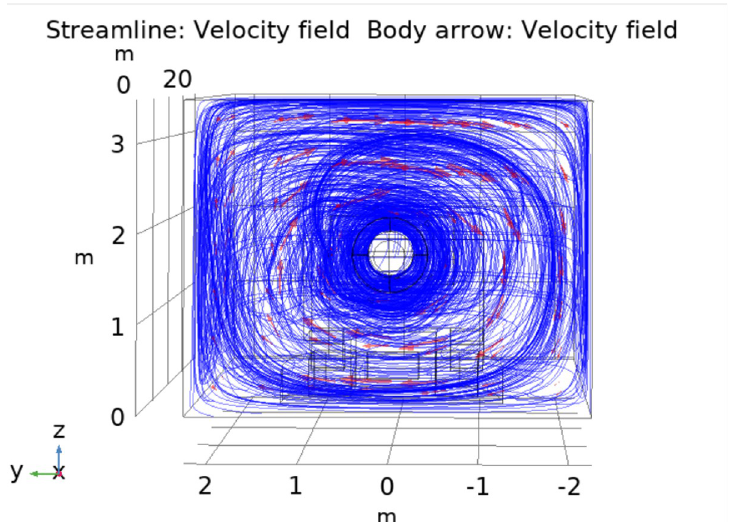
Fig 8. Main view of the airflow streamline and